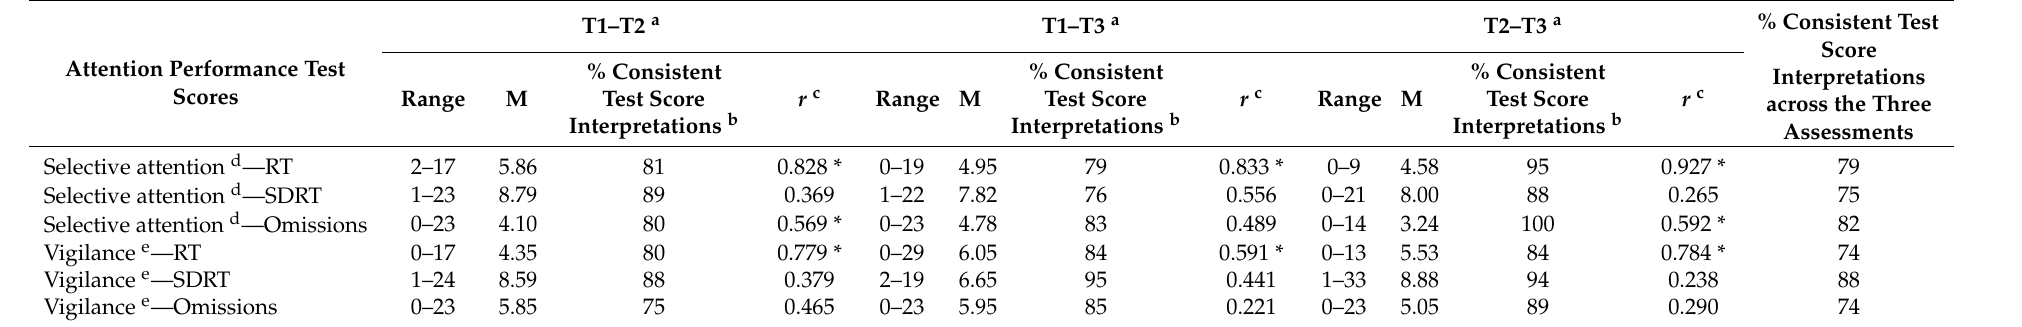
Table 3. Stability of attention performance and correlations between attention scores of the three assessments of individuals with ADHD ( n = 21).